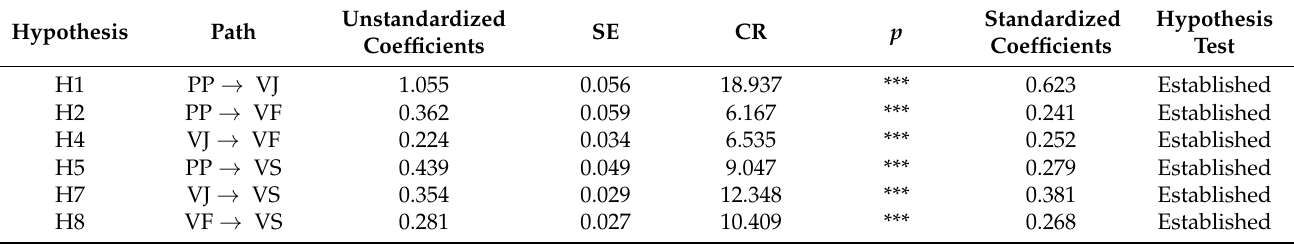
Table 6. The test results of path